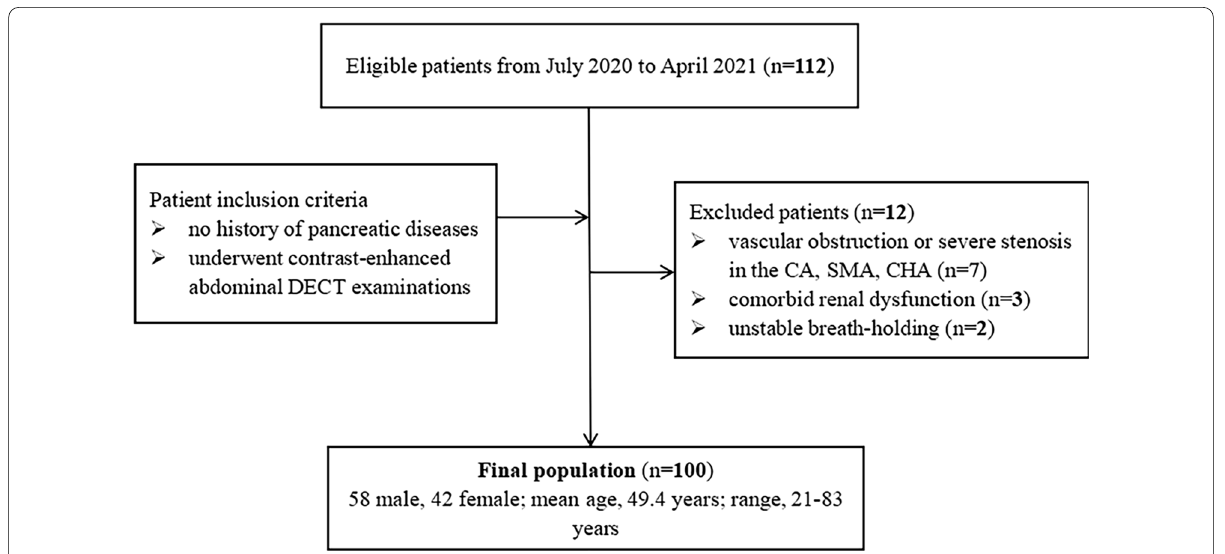
Fig. 1 Flowchart of the included and excluded